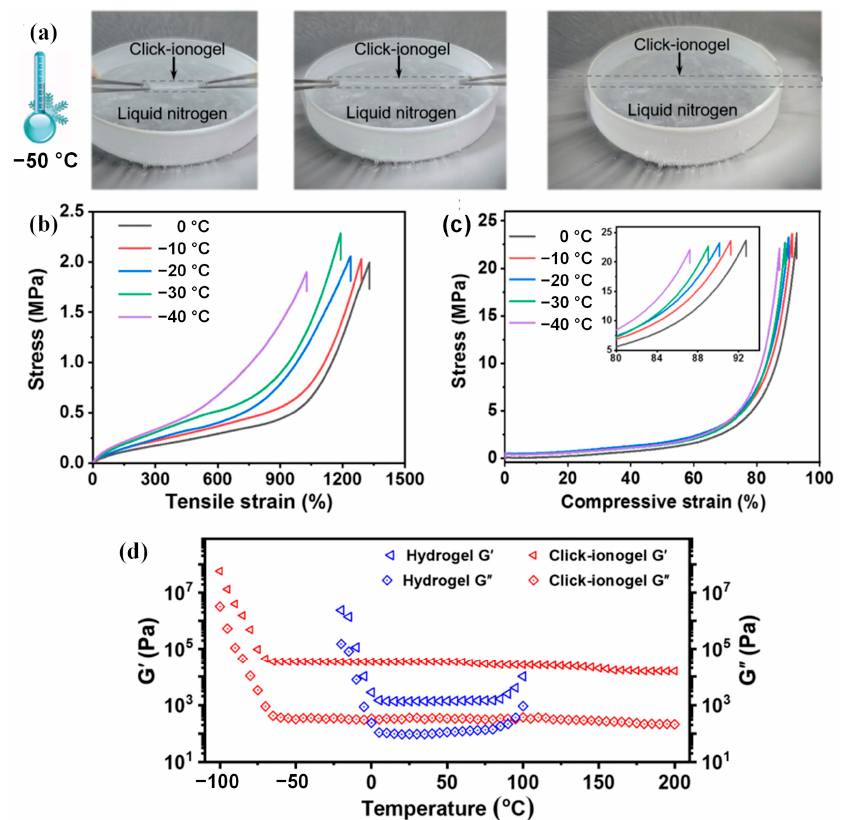
Figure 4. Mechanical properties of click-ionogels at low temperature: ( a ) Images of click ionogels stretching at approximately − 50 °C; ( b ) Tensile stress-strain curves for click ionogels; ( c ) Compres- stretching at approximately − 50 ◦ C; ( b ) Tensile stress-strain curves for click ionogels; ( c ) Compressive sive stress-strain curves for click ionogels; ( d ) Storage moduli (G ′ ) and loss moduli (G ″ ) of hydrogels stress-strain curves for click ionogels; ( d ) Storage moduli (G (cid:48) ) and loss moduli (G”) of hydrogels and and click-ionogels. Reprinted with permission from [45]. click-ionogels. Reprinted with permission from